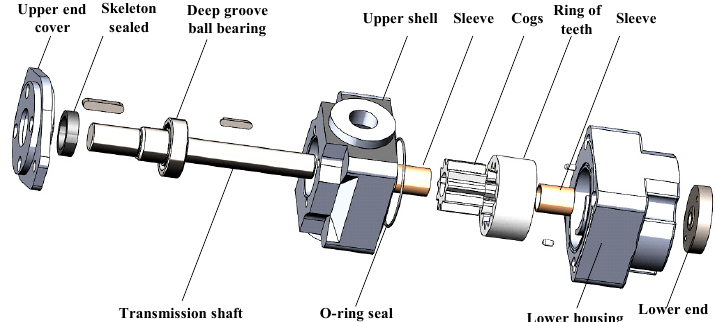
Figure 4. Structure of the internal gear pump. Table 2. Primary technical parameters of the internal gear pump.